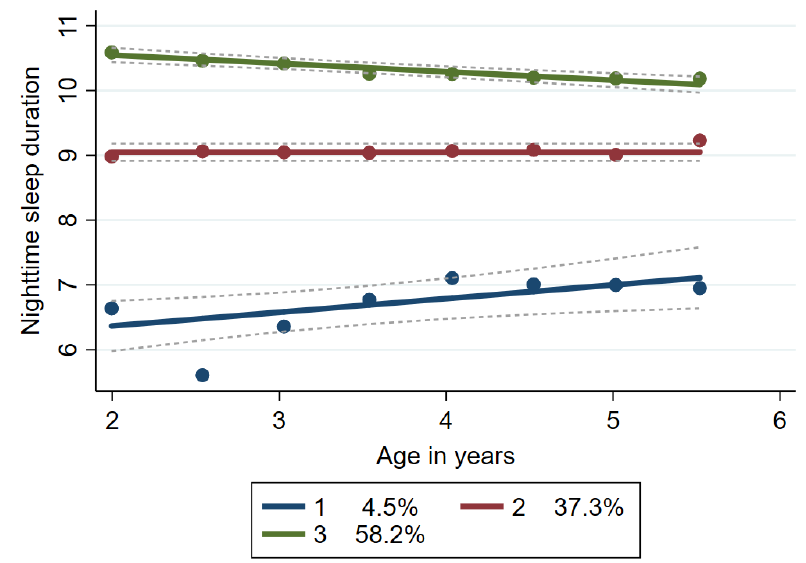
Figure 1. Trajectories of nightly sleep duration from age 2 years to age 5.5 years; 559 children enrolled in Center for Oral Health Research in Appalachia Cohort 2 between 2012 and 2018; 1—short duration; 2—steady; 3—longer duration.